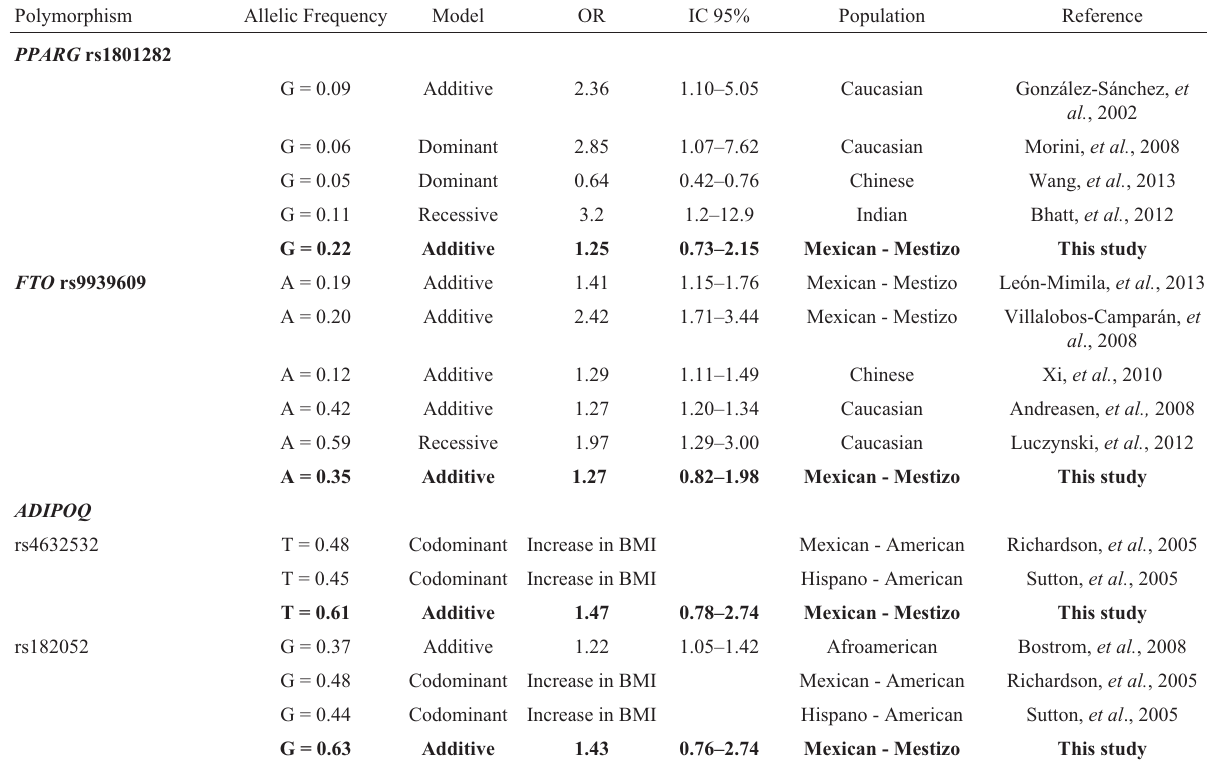
Table 3 - Comparison of association of FTO rs9939609, PPARG2 rs1801282, and ADIPOQ rs4632532 and rs182052 with obesity in different popula-